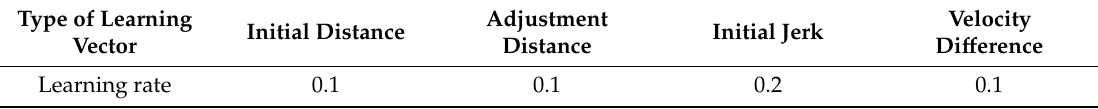
Table 5. Values of learning rate according to the driver